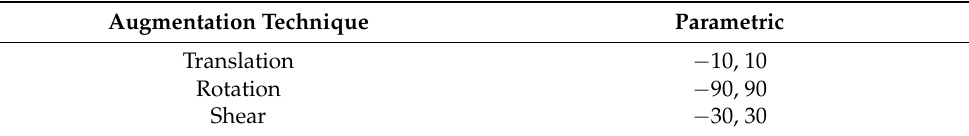
Table 4. Parametric values of data-augmentation techniques. Augmentation Technique Parametric